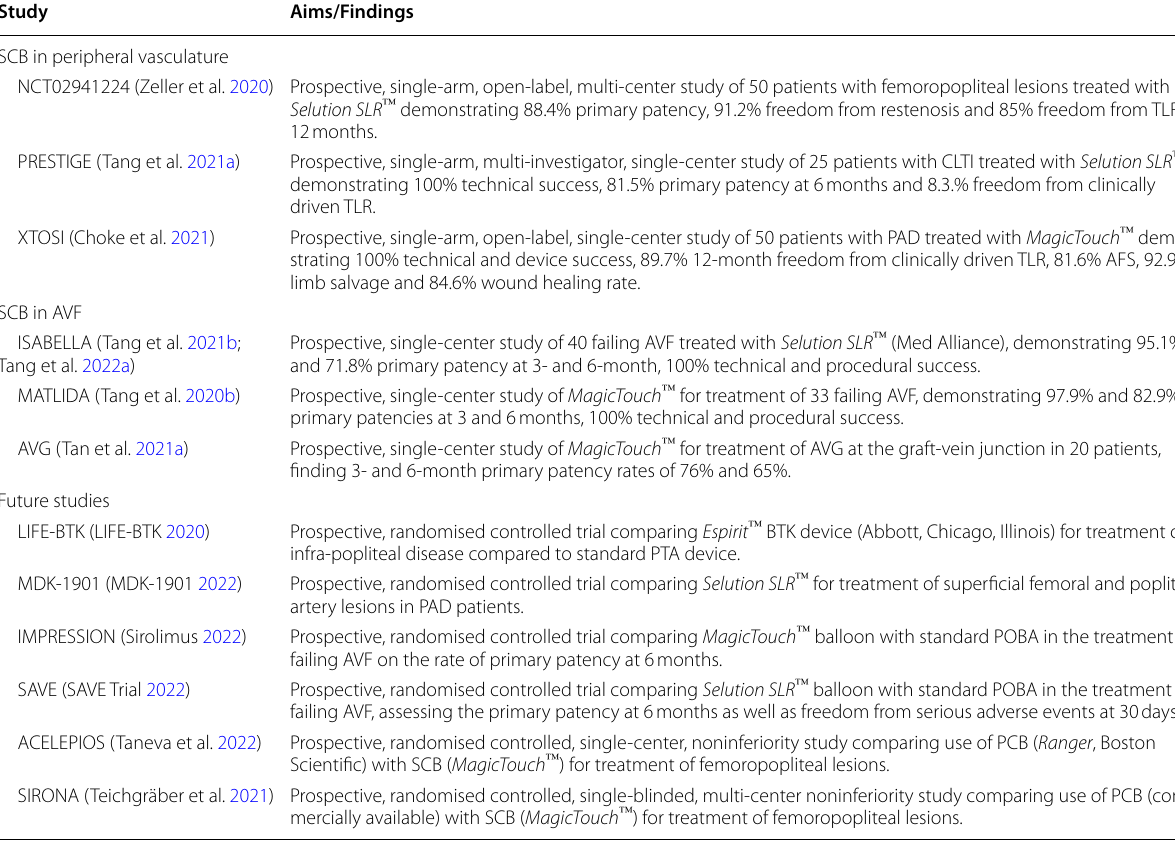
Table 1 Summary of evidence of use of sirolimus coated balloons Study